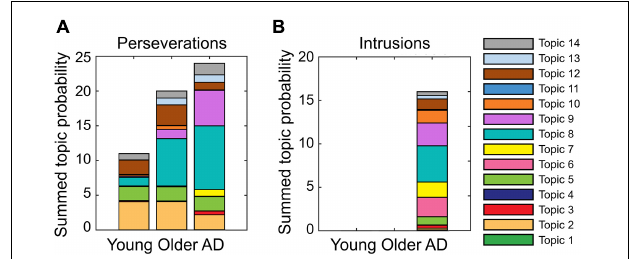
FIGURE 1 | Proportion of summed topic probabilities for each topic in (A) perseverations and (B) intrusions. Note that the intrusions committed by healthy older adults, (“kemse” and “lojør”) are unknown utterances. As such, they are not found in Wikipedia articles, and accordingly, they have no topic probabilities. Likewise, two out of the 18 intrusions committed by patients with Alzheimer’s disease (AD) (“rose bed” and “pusi”) were not found in the Norwegian Wikipedia articles.